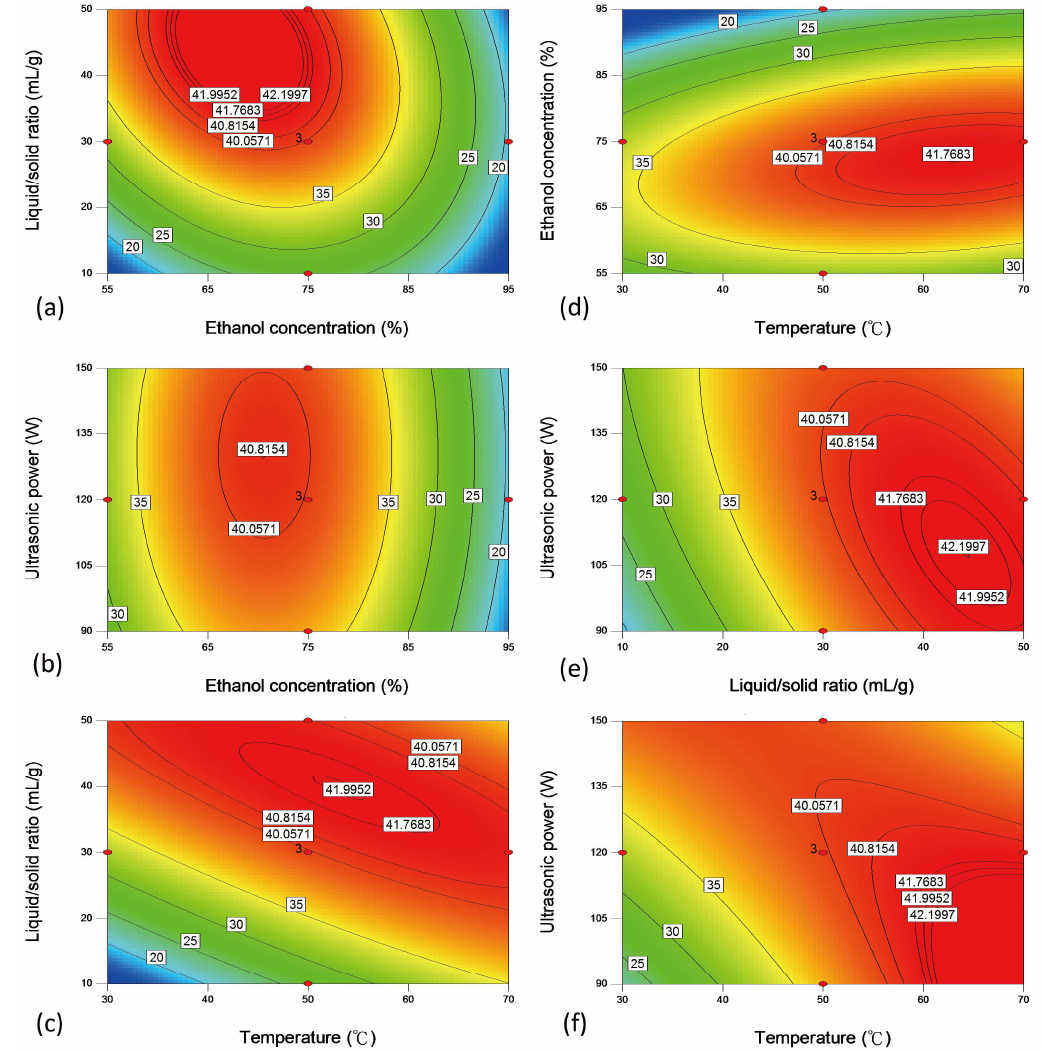
Figure 4. Contour plots are showing the relationships between responses variable and independent variables. ( a ) Ethanol concentration compared to L/S ratio; ( b ) ultrasonic power compared to ethanol concentration; ( c ) L/S ratio compared to temperature; ( d ) ethanol concentration compared to temperature; ( e ) ultrasonic power compared to L/S ratio; ( f ) ultrasonic power compared to temperature.